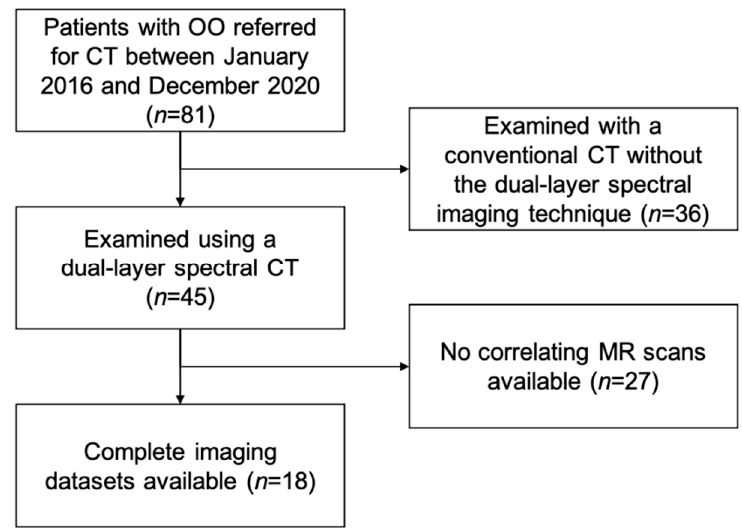
Figure 1. Flowchart illustrating patient selection.